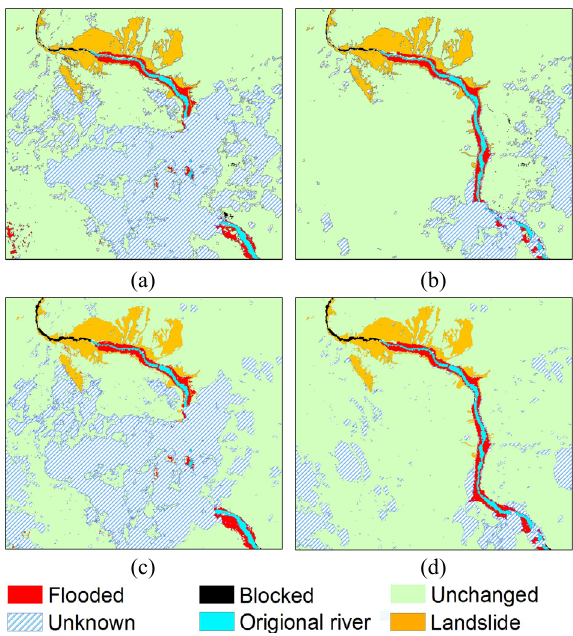
Figure 3. Post-classification comparison result with single pair of pre- and post-disaster images. (a) Detection result with (a) - (c) in Figure 2; (b) Detection result with (a) - (d in Figure 2; (c) Detection result with (b) - (c) in Figure 2; (d) Detection result with (b) - (d) in Figure 2.The original river (blue) and landslide area (yellow) are added manually based on the ground truth.